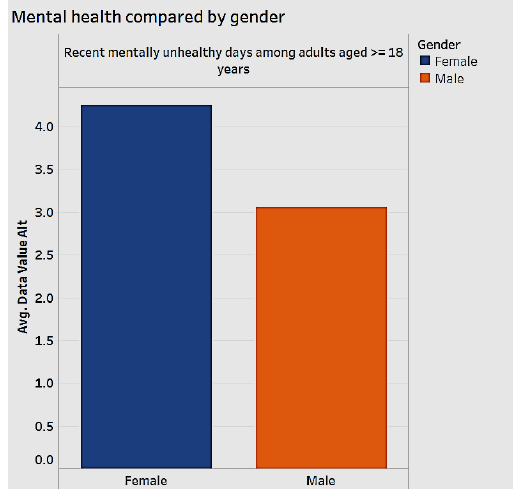
Figure 8. Mental health by gender.